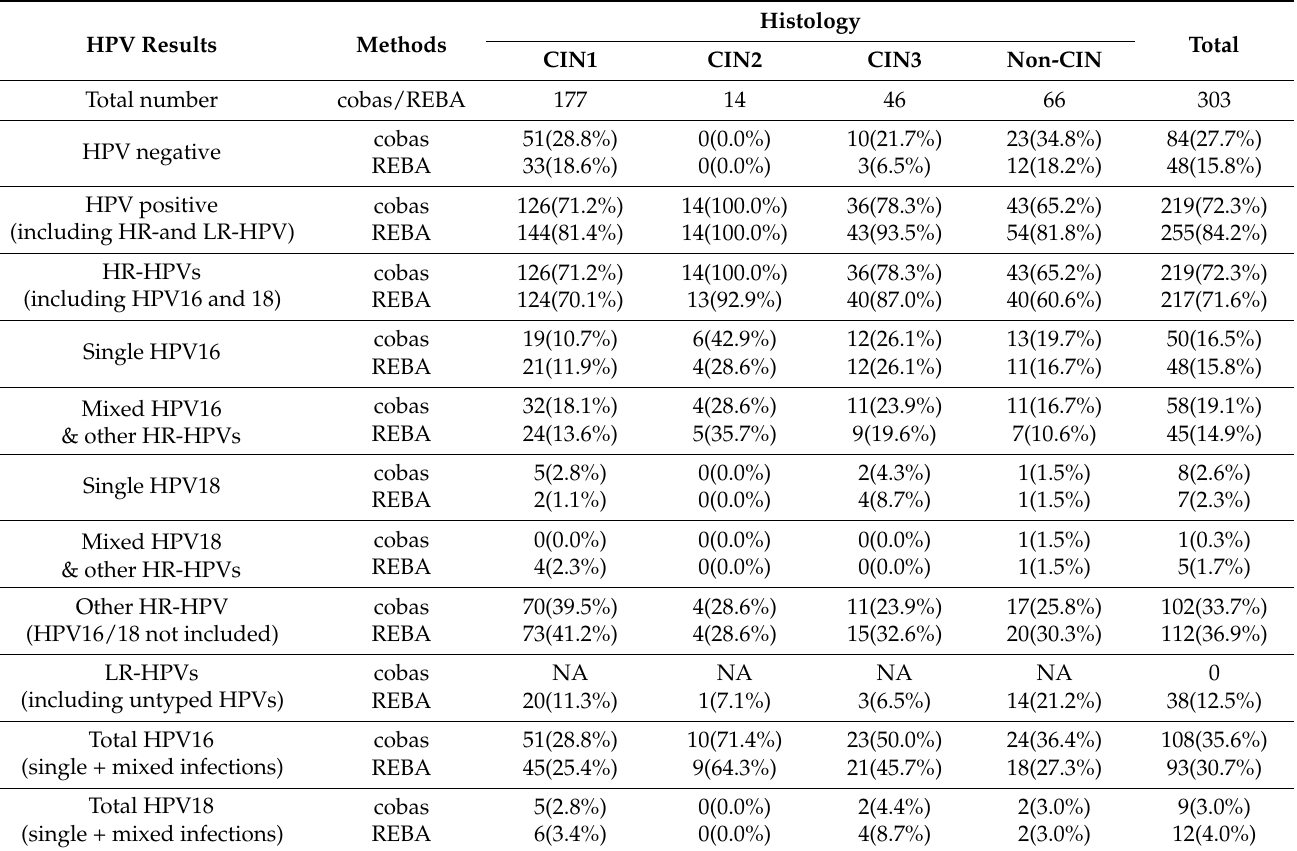
Table 1. HPV DNA detection by the cobas ® 4800 and REBA-HIV-ID ® assays, stratified histologically, in 303 samples.